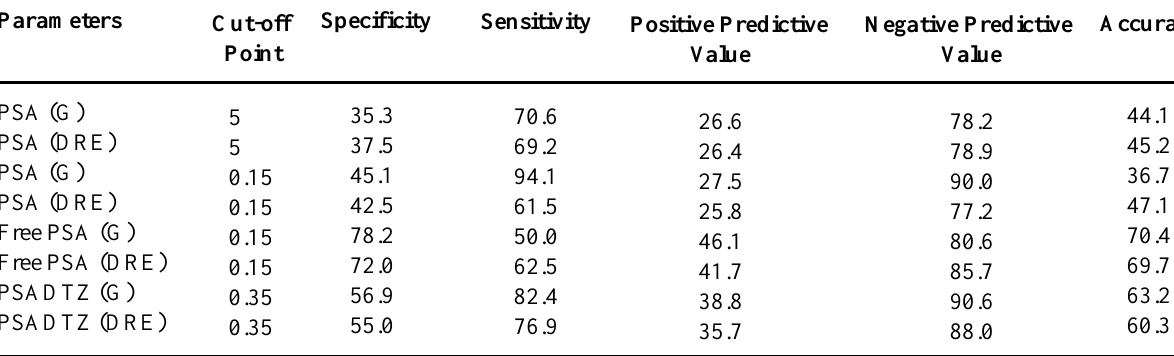
Table 3 – Performance measurements for PSA parameters in the general (G) and negative digital rectal examination (DRE) groups.